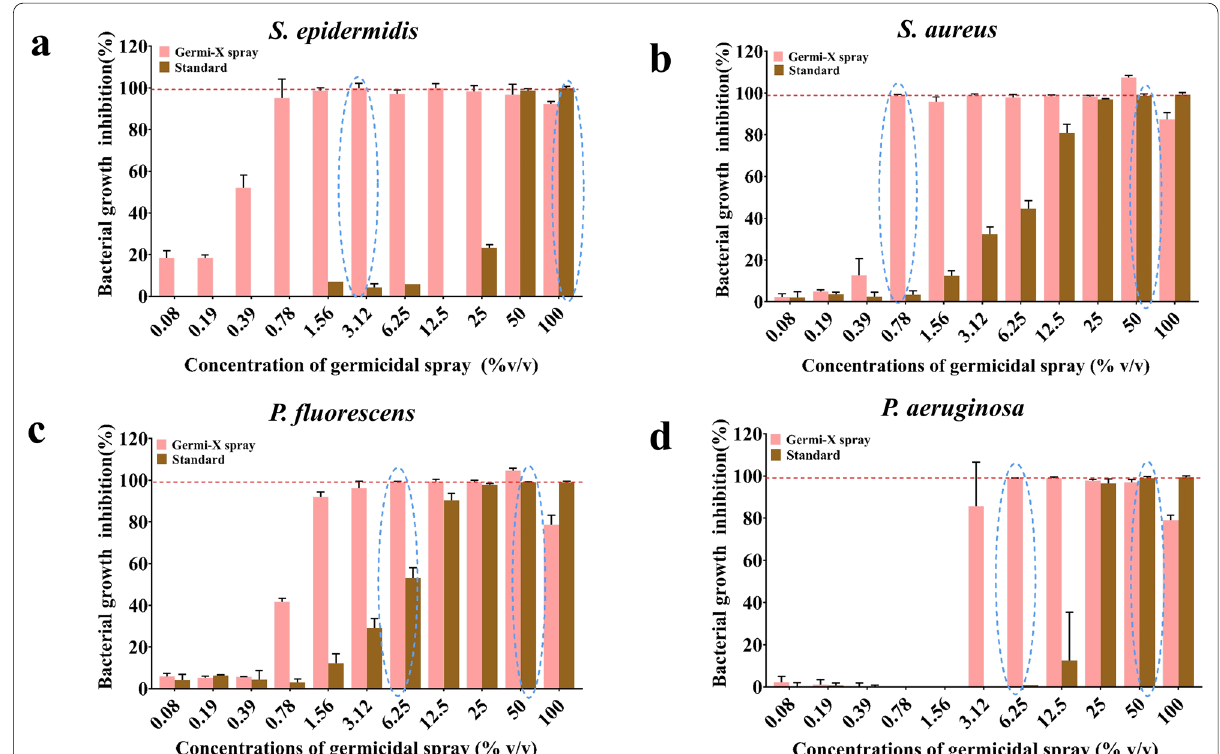
Fig. 2 Germicidal effect of Germi-X spray on different surface pathogenic bacteria. a – d Grouped column graphs representing comparisons between % bacterial growth inhibition exhibited by Germi-X spray and standard germicidal spray against S. epidermidis ( a ), S. aureus ( b ), P. fluorescens ( c ) and P. aeruginosa ( d ). The red broken lines are used to indicate 99% of the respective bacterial growth and blue open oblongs are used to mark the concentrations of Germi-X spray and standard at which 99% inhibition of respective bacterial growth was